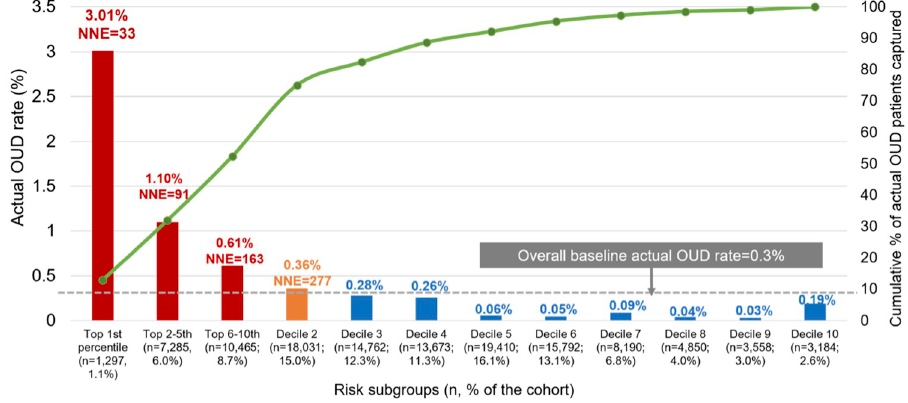
Fig 2. Incident OUD identified by elastic net’s decile risk subgroup in the validation sample (n = 120,497) a . Abbreviation: OUD: opioid use disorder. a : Based on the individual’s predicted probability of an OUD event, we classified beneficiaries in the validation sample into decile risk subgroups, with the highest decile further split into 3 additional strata based on the top 1, 2nd to 5th, and 6th to 10th percentiles to allow closer examination of patients at highest risk of developing